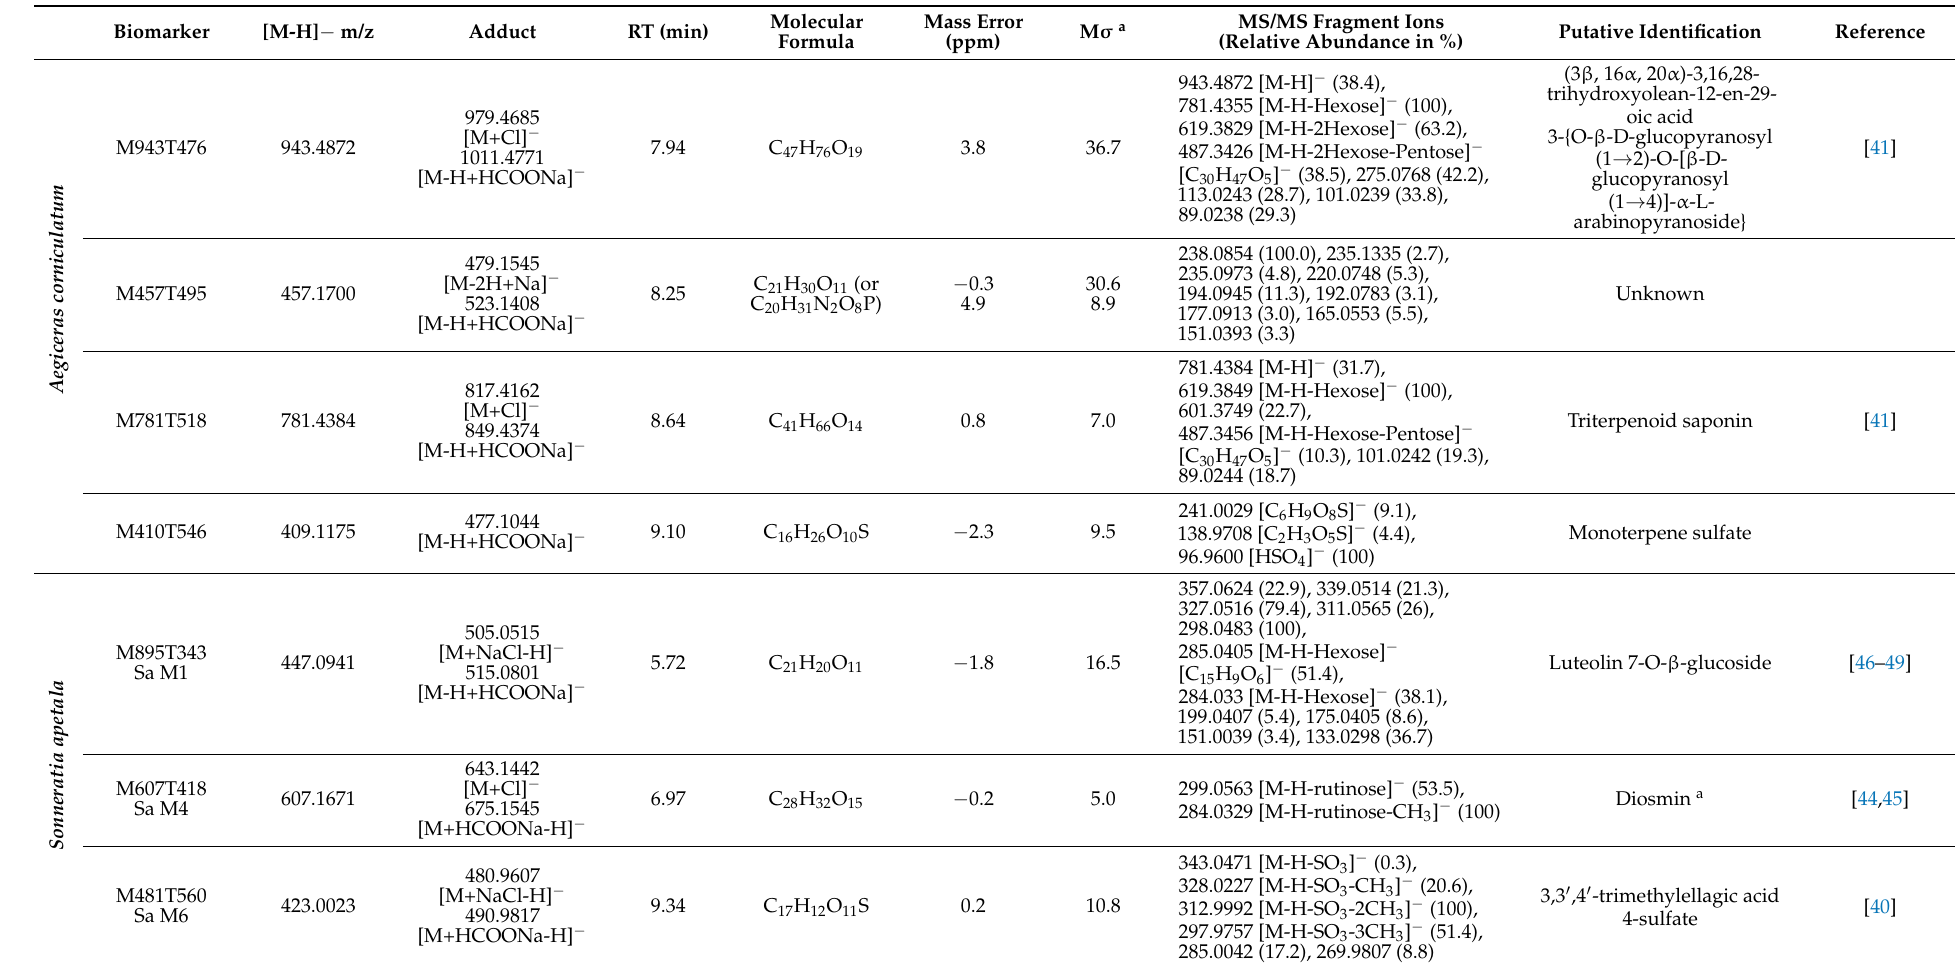
Table 2. List of Aegiceras corniculatum and Sonneratia apetala leaf methanolic extracts’ biomarkers detected via